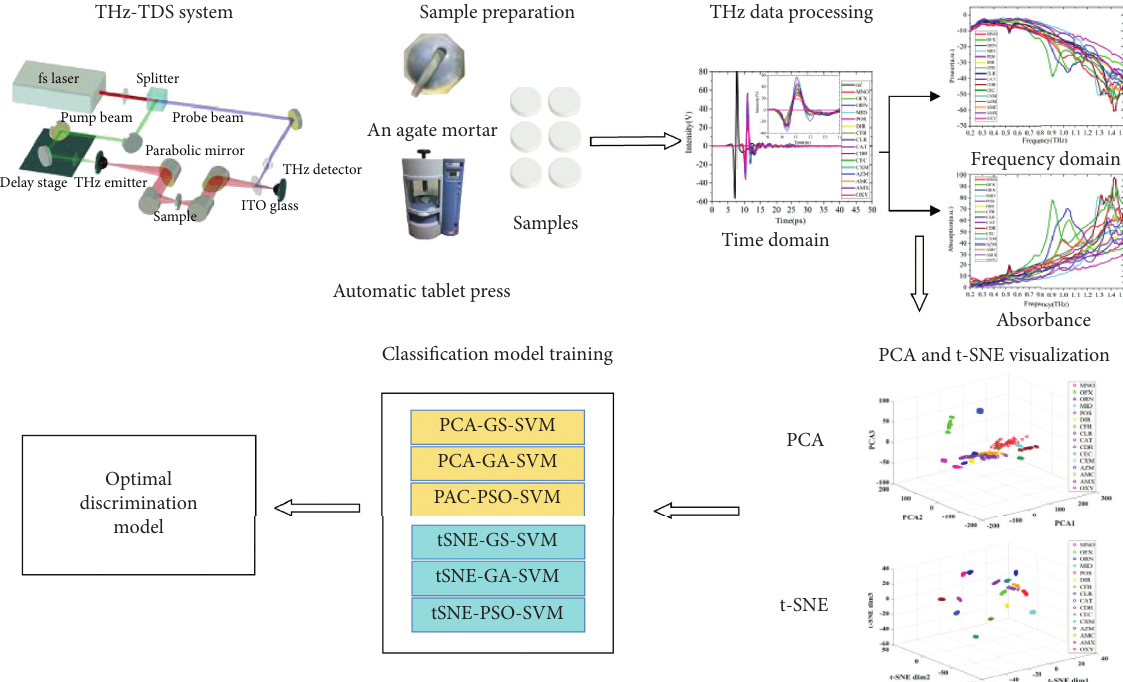
Figure 1: Experimental layout of terahertz spectroscopy system.